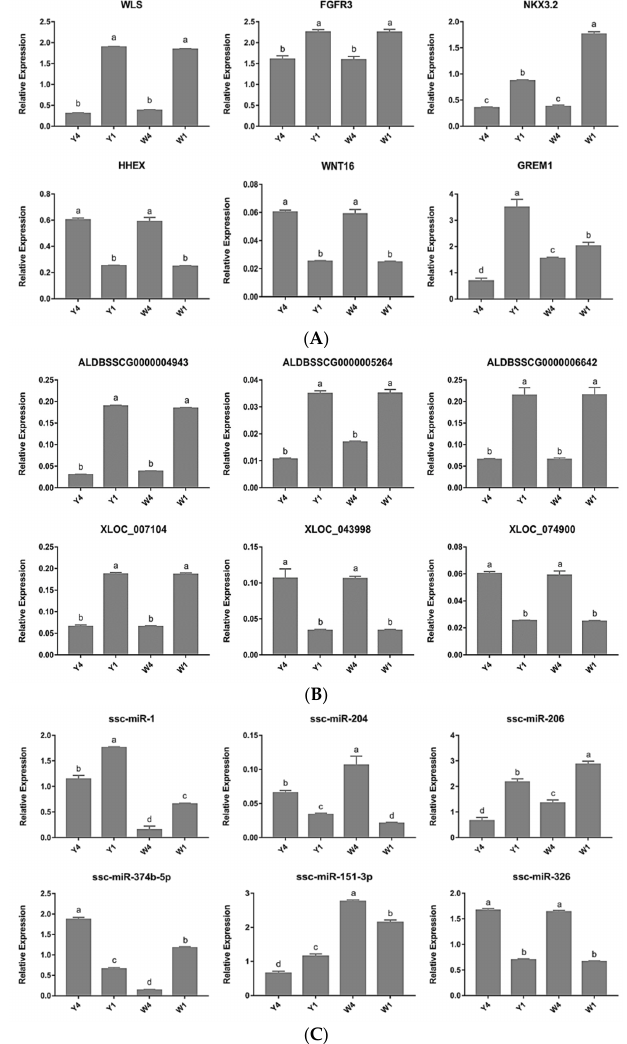
Figure 4. Quantitative PCR-verified RNA-seq results (Y4 vs. Y1; W4 vs. W1; Y4 vs. W1; and Y1 vs. W1). The differentially expressed mRNAs ( A ), lncRNAs ( B ), and microRNAs ( C ) were confirmed by quantitative PCR. Results are shown as means ± SDs of triplicate measurements. Different letters indicate significant differences; the same letters indicate no significant differences. Y1, 1-month-old Yorkshire pigs; Y4, 4-month-old Yorkshire pigs; W1, 1-month-old Wuzhishan pigs; W4, 1-month- old Wuzhishan pigs.